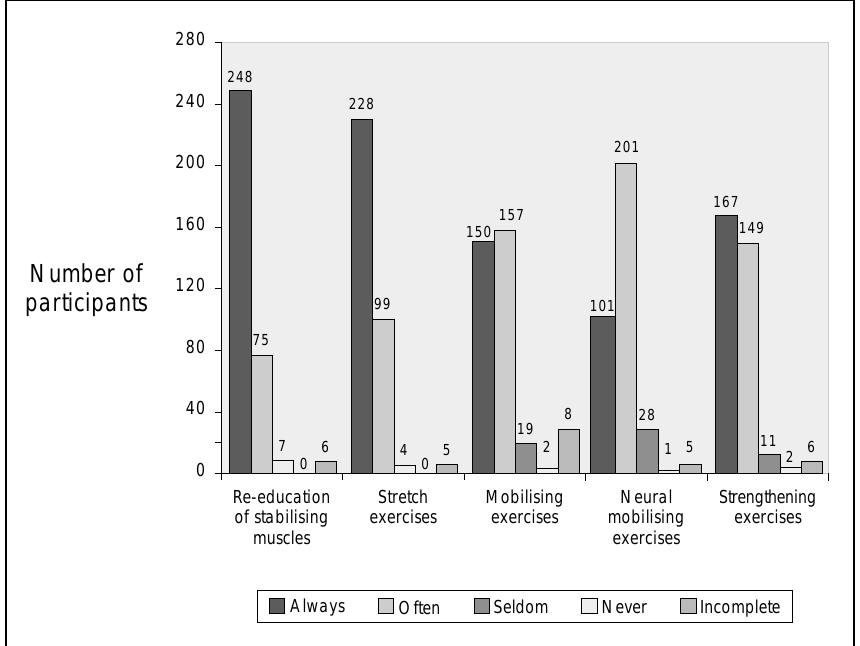
Figure 6: Types of exercises utilised during exercise